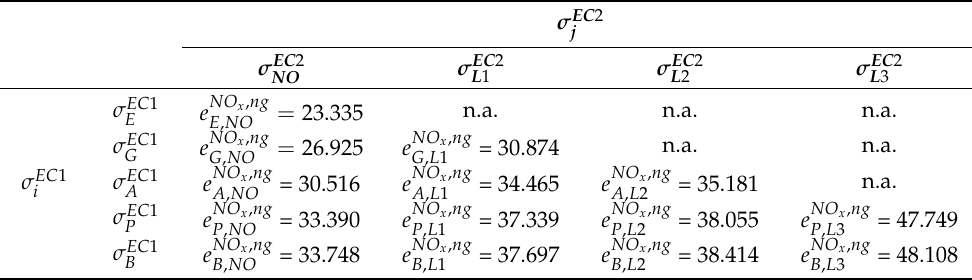
Table 8. Computational results of the virtual NO x emission in kg within one cycle.